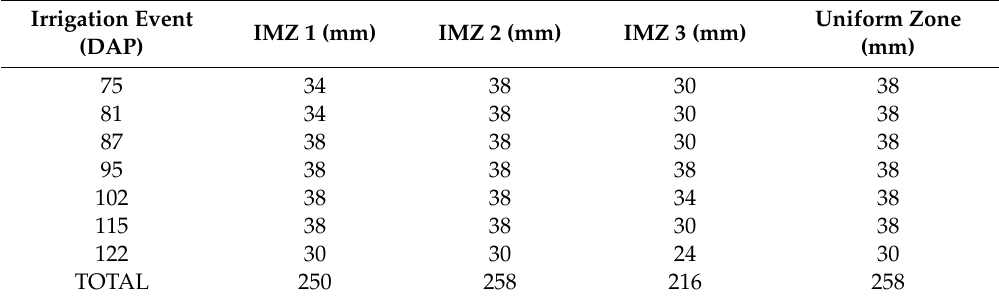
Table 1. Irrigation supplied during the 2015 growing season for all IMZs and the uniform zone. Irrigation